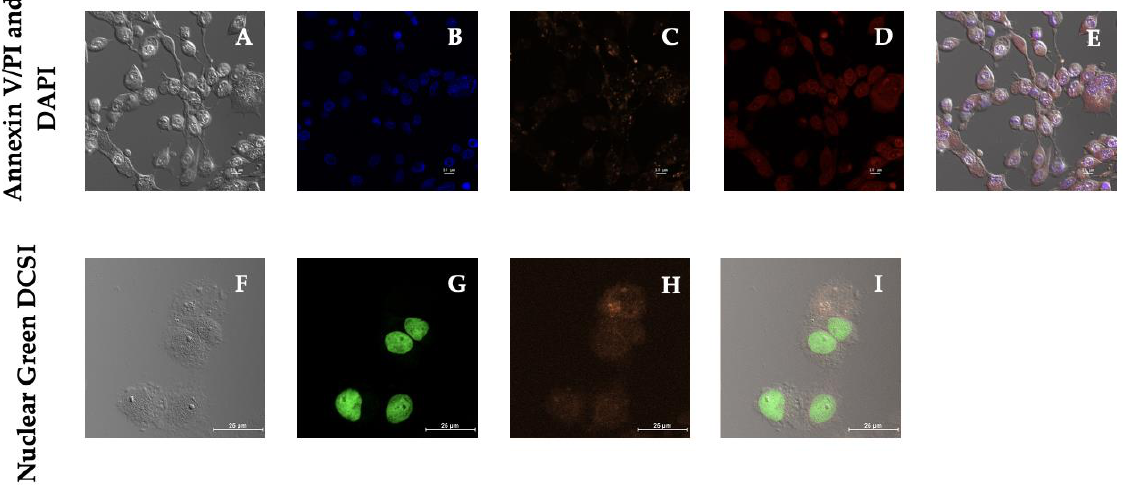
Figure 7. Dead cell studies after 24 h of incubation with PSI-LHCI (12.5 µg/mL). Phase-contrast images are shown in ( A , F ). MDA-MB-231 cells were treated with PSI-LHCI ( C ) and stained with DAPI ( B ) and PI ( D ) to determine apoptosis and PSI-LHCI localization. Merged image in magenta ( E ) represents the colocalization of DAPI (blue) and PI (red) staining and PSI-LHCI (orange) localization in MDA-MB-231 cells. Annexin V/PI and DAPI images were taken at 20 × magnification. Scale bars, 10 μm. MDA-MB-231 cells were treated with orange PSI-LHCI ( H ) and stained with nuclear green DCS1 ( G ). Merged image ( I ) represents the analysis of dead cells. Nuclear Green DCS1 images were taken at 60 × magnification. Scale bars, 25 μm.